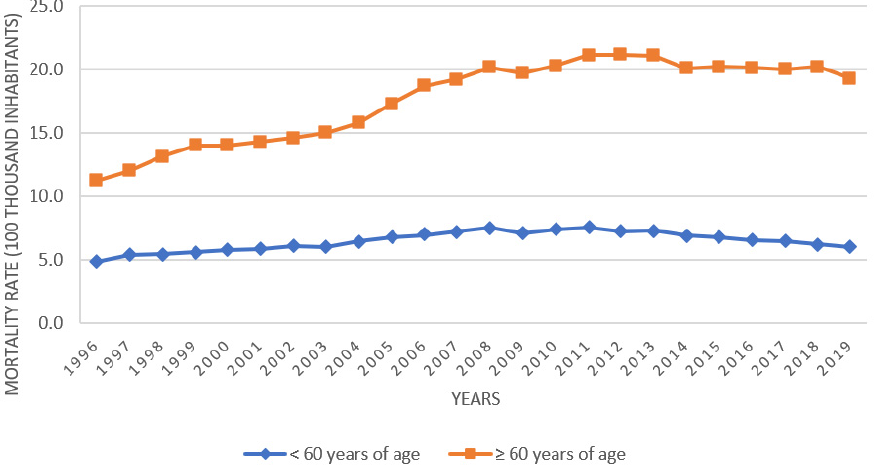
Figure 2. Evolution of the mortality coefficient from abusive alcohol consumption for age groups under 60 years and for the elderly population, from 1996 to 2019, in Brazil.